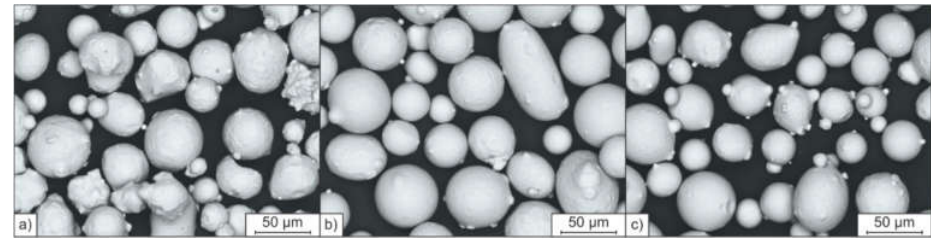
Figure 3. Morphologies of the starting powders; ( a ) A, ( b ) B, ( c ) C. Regarding the particle shape distribution measurement using dynamic image analysis, powder A shows a higher range in particle size and scatter than the other two starting materials (Figure 4). The minimum powder sizes for the three powders are given in Table 4. The maximum particle size was measured for powder B. For all three starting materials, the largest powder particles result from the agglomeration of the smaller particles during the atomization process (satellites). However, in the case of powder A, the agglomerated powder particles possess sharper corners, suggesting that they resulted from the agglomeration of smaller powder particles compared to the B and C powders. Powders B and C show relatively bulkier agglomerated particles owing to the different gas atomization setup that was used in comparison to powder A. The largest agglomerates are found for powder B. This can be a reason for the increased Carney flow time and angle of repose of powder B. It can be assumed that the different chemical compositions of powders B and C influence the atomization process.